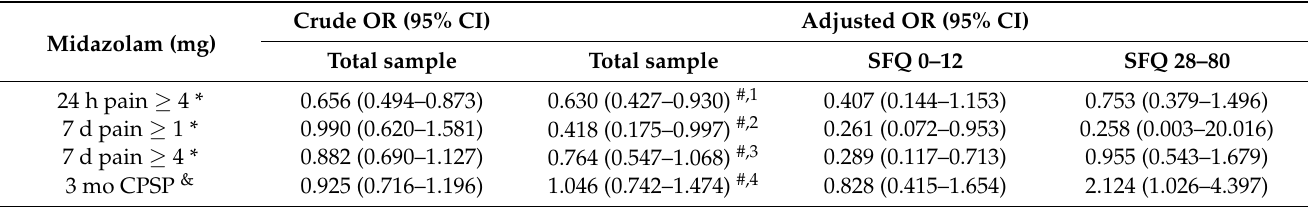
Table 3. Logistic regression models for the effect of midazolam on postsurgical